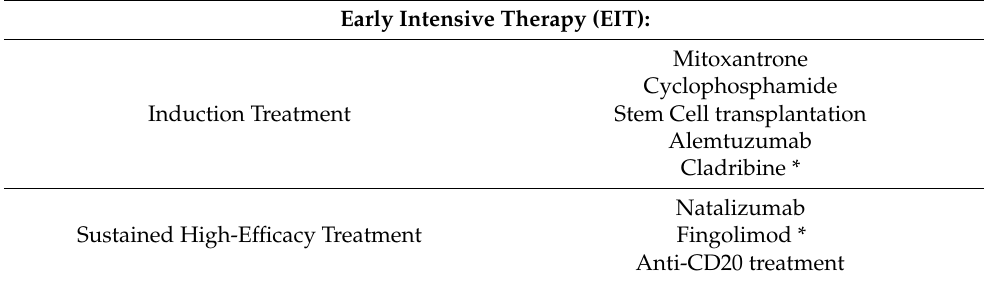
Table 1. Early Intensive Therapy. * There is not consensus regarding Cladribine and fingolimod (as some authors consider them HET and others